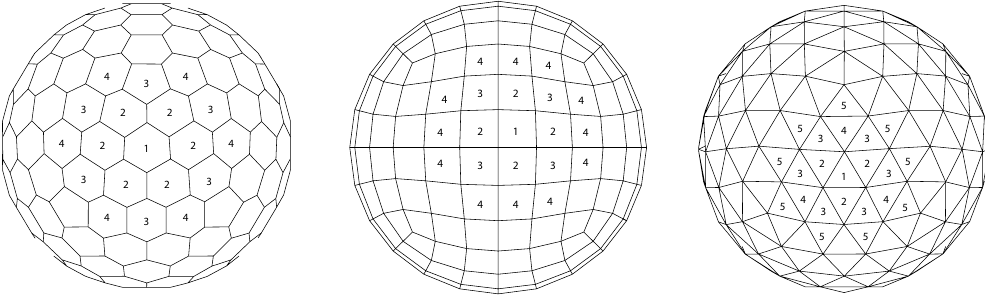
Figure 3. Schematics showing how the advection scheme stencils are iteratively constructed on various grid structures. A number m indicates a cell added to the stencil at the m th